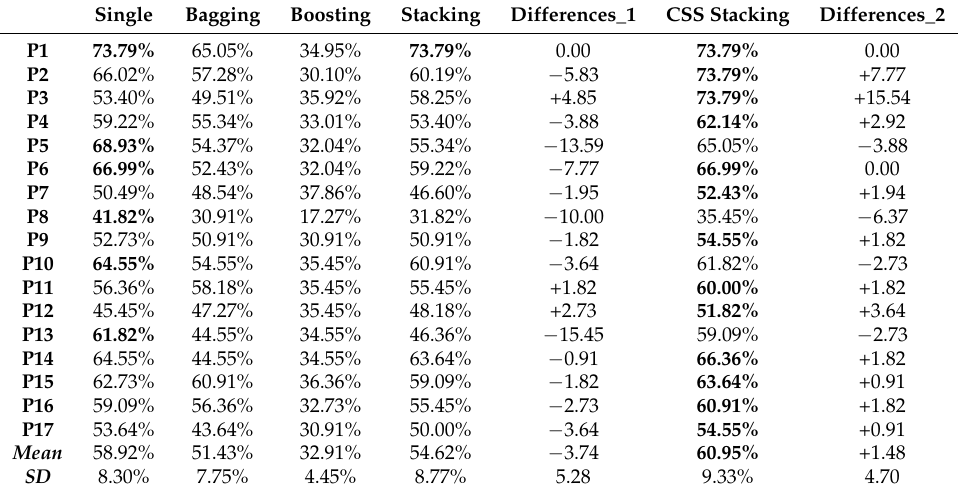
Table 5. First phase. Best accuracy per person by using each classification method. Improvements comparing the best accuracy from multi-classifiers (bagging, boosting and stacking) against single classifiers are presented in the Differences_1 column. In addition, the improvements between the CSS stacking with EDA and the best accuracy from both single and standard multi-classifiers are shown in the Differences_2 column. Mean and SD rows denote the average and standard deviation for each classification method and the type of differences considering all of the actors. Differences are expressed in percentage